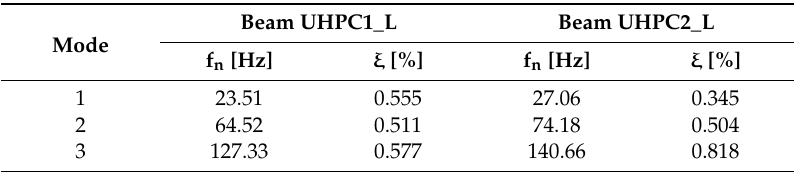
Table 4. Modal parameters for the first three modes (least squares complex exponential (LSCE) method) in the intact state of the beams.